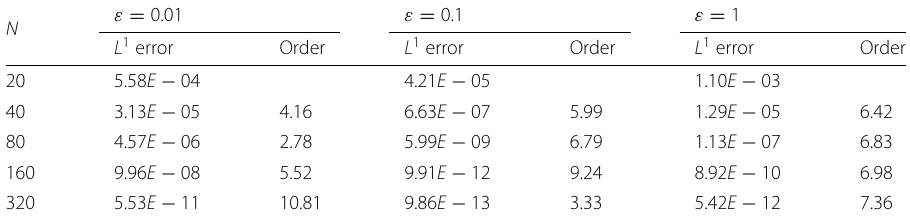
Table 6 Example 1. L 1 errors and numerical orders of spatial accuracy obtained with the GSA IMEX-ARS3 WCNS at t =